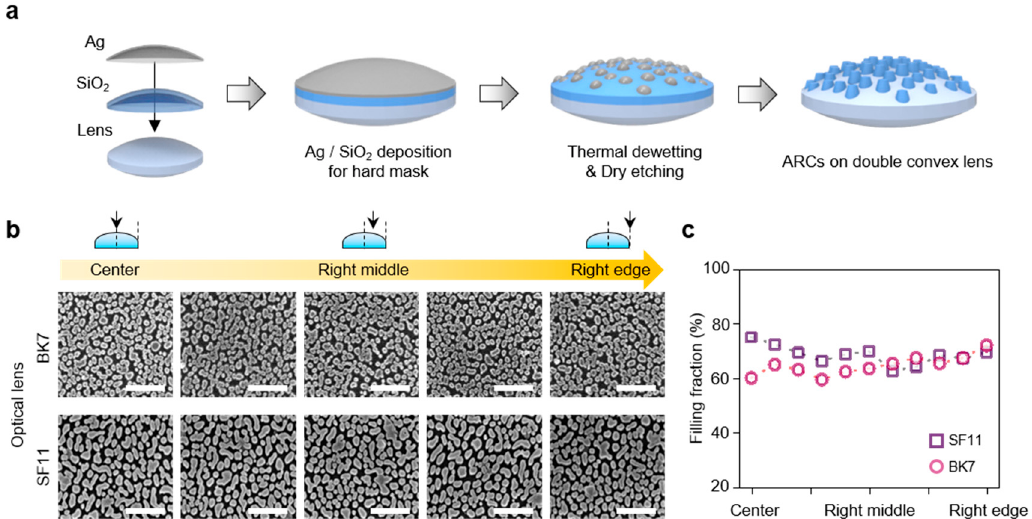
Figure 3. ( a ) Schematic illustration of fabrication process steps. ( b ) SEM images (1500 nm × 1300 nm) showing a top view in terms of position from center to edge of BK7 lens and SF11 lens. Scale bar is 500 nm. ( c ) Comparison of the filling fraction in terms of position from the center to the right edge.